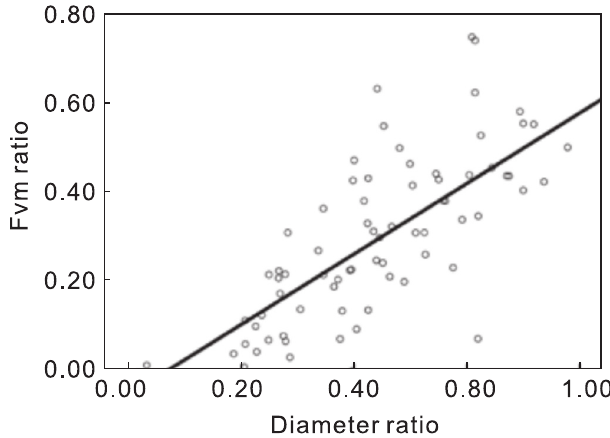
Figure 2 The linear correlation of the J1 diameter ratio and FVm